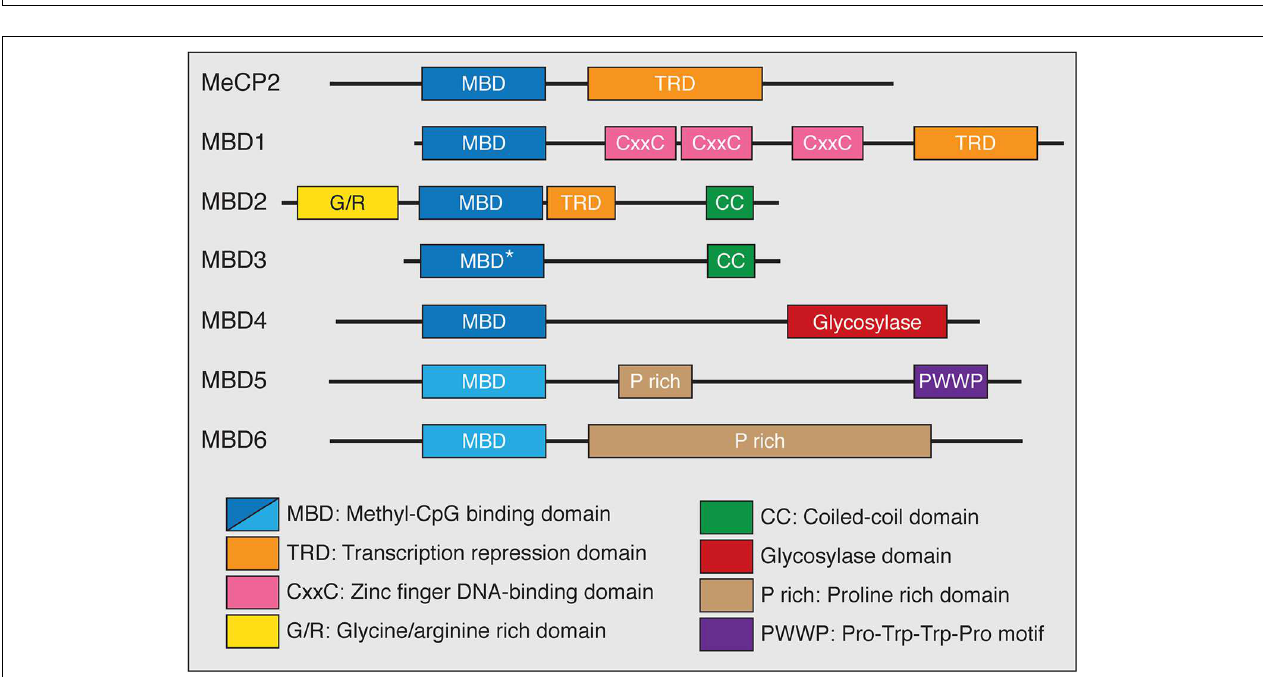
FIGURE 2 | The MBD family of proteins. All MBD family proteins contain a highly conserved MBD (blue box) in addition to other functional domains. The MBD of MBD3 has a point mutation ( ∗ ) that abolishes methyl-CpG binding. MBD5 and MBD6 do not specifically bind methyl-CpG (lighter blue box). MeCP2, MBD1, and MBD2 contain C-terminal transcriptional repression domains (TRD) that interact with co-repressor protein complexes (orange box). MBD1 has CxxC-type zinc finger domains which mediate DNA binding. MBD2 has an N-terminal glycine/arginine rich domain (yellow box) and a C-terminal coiled-coil domain, which is also found in MBD3 (green box). The functions of MBD4 are mediated through a C-terminal glycosylase domain (red box). Both MBD5 and MBD6 contain proline rich domains (tan box) while MBD5 has a PWWP motif (purple box) that binds methylated histones.